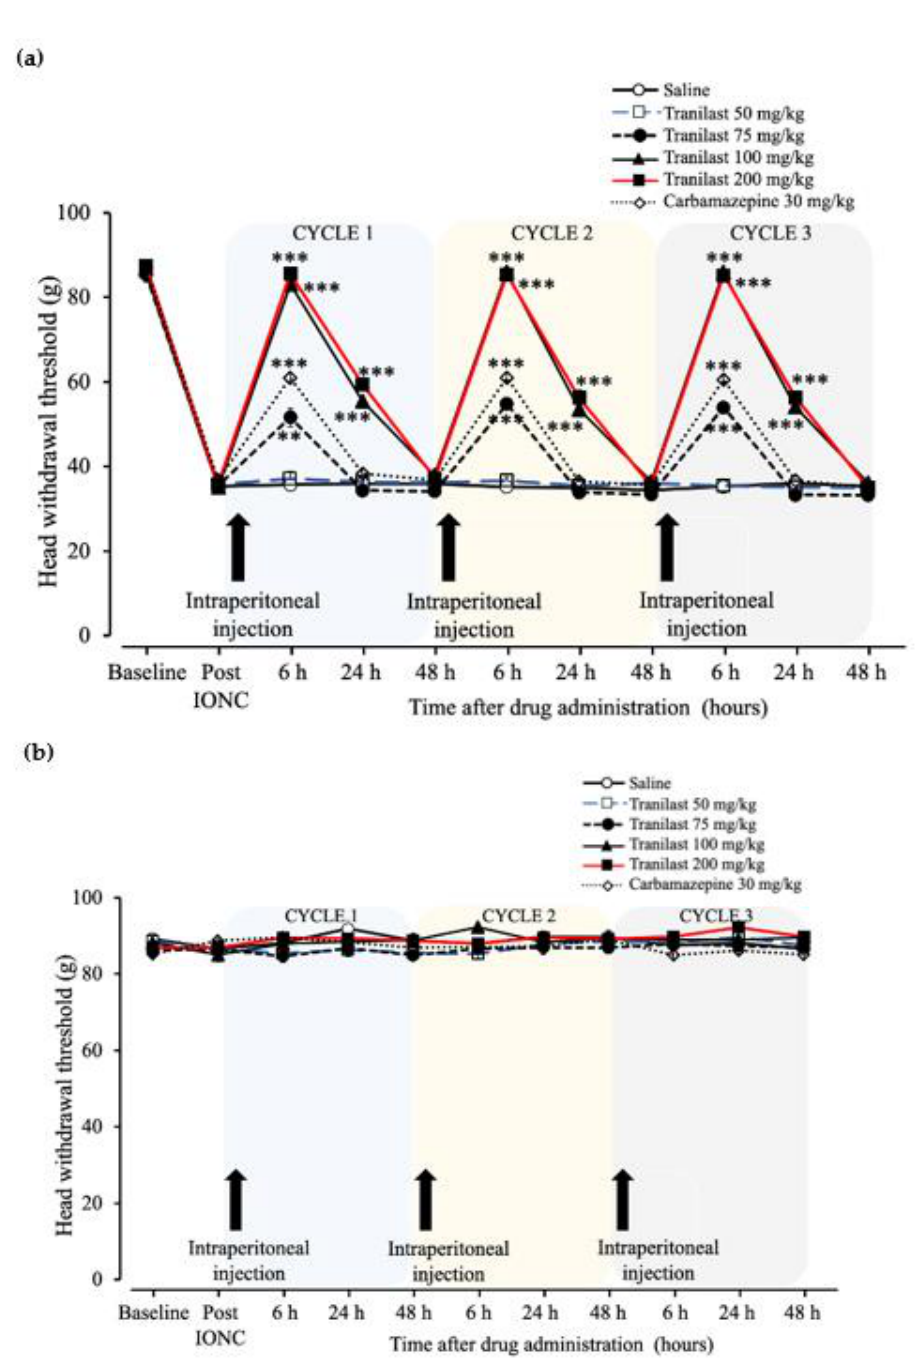
Figure 3. Head withdrawal threshold to mechanical stimuli after intraperitoneal injection of tranilast, carbamazepine or saline. ( a ) Ipsilateral side head withdrawal threshold in the neuropathic pain model following intraperitoneal administration of tranilast (50–200 mg/kg), carbamazepine (30 mg/kg) or saline injection. The experiment outcome is shown in three repetitive cycles. The behavioral responses to mechanical stimuli of the tranilast and carbamazepine groups are compared to the saline group. Doses of 100 and 200 mg/kg of tranilast showed increased head withdrawal thresholds at 6–24 h. Tranilast 75 mg/kg and carbamazepine (30 mg/kg) showed increased thresholds at 6 h and thereafter showed a rebound in threshold similar to that in the saline group. Tranilast 50 mg/kg did not show any changes in response to mechanical stimuli. ( b ) The contralateral side head withdrawal threshold showed no changes. The head withdrawal thresholds are represented as mean ± SEM. n = 6 per group. ** p < 0.01, *** p < 0.001, repeated measures analysis of variance followed by Tukey’s HSD